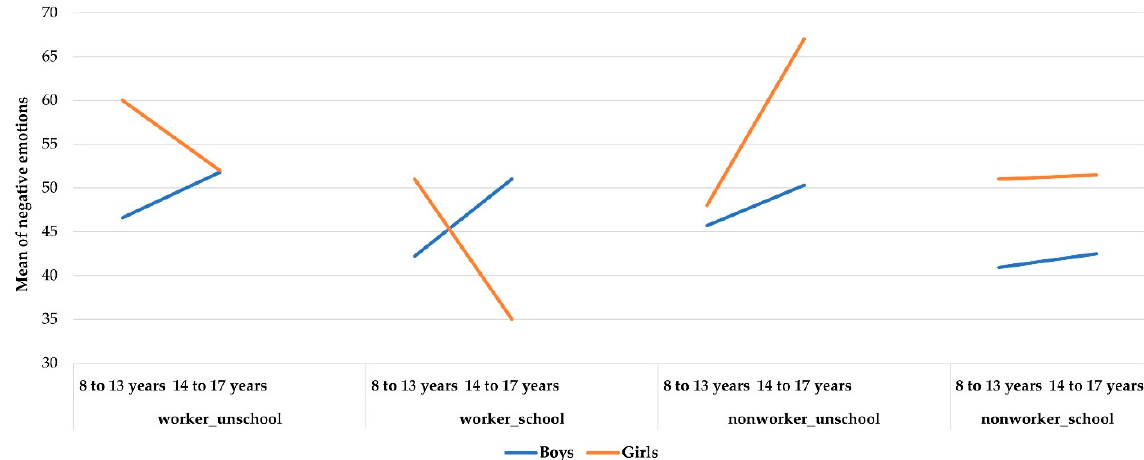
Figure 2. Gender differences for Negative Emotions.